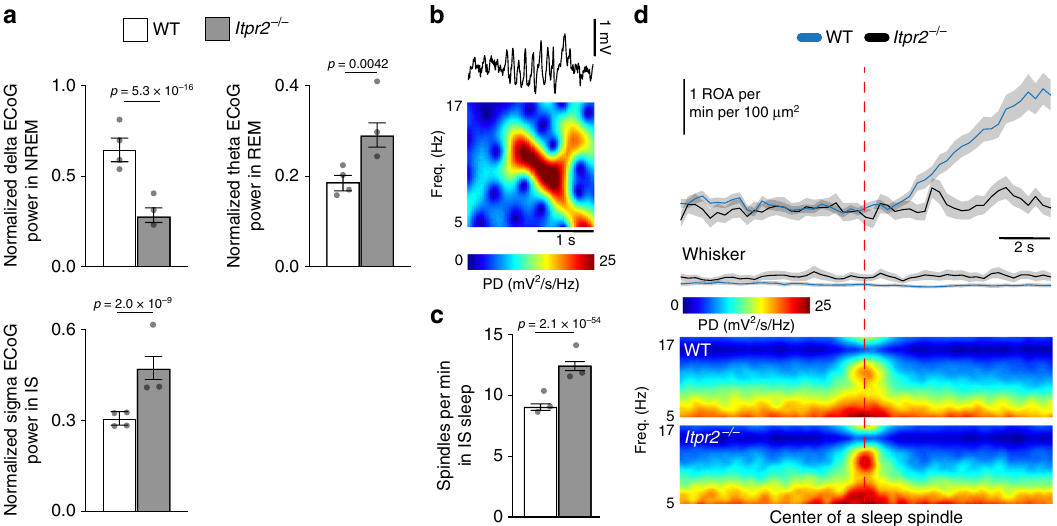
Fig. 9 Astrocytic IP 3 -mediated Ca 2 + signaling during sleep spindles. a Mean ECoG power of delta (0.5 – 4 Hz) frequency during NREM sleep, theta (5 – 9 Hz) frequency during REM sleep, and sigma (10 – 16 Hz) frequency during IS sleep, normalized to 0.5 – 30 Hz total power. For WT mice: n = 4 mice, 785 NREM episodes, 668 IS episodes, 102 REM episodes; for Itpr2 − / − mice: n = 3 mice, 957 NREM episodes, 648 IS episodes, 74 REM episodes. b Representative example of a sleep spindle in ECoG trace and power spectrogram. c Mean number of spindles per minute during IS sleep. For WT mice: n = 3 mice, 516 IS episodes; for Itpr2 − / − mice: n = 3 mice, 560 IS episodes. d Mean± SEM (top to bottom) astrocytic Ca 2 + signals, whisker movement z - score and ECoG power spectrograms aligned to the beginning of a sleep spindle. For WT mice: n = 6 mice, 243 sleep spindles; for Itpr2 − / − mice: n = 6 mice, 93 sleep spindles. Data represented as estimates± SE and p -values (two-sided test, no adjustment for multiple comparisons) derived from linear regression models unless otherwise stated. For details on statistical analyses, see “ Methods ”